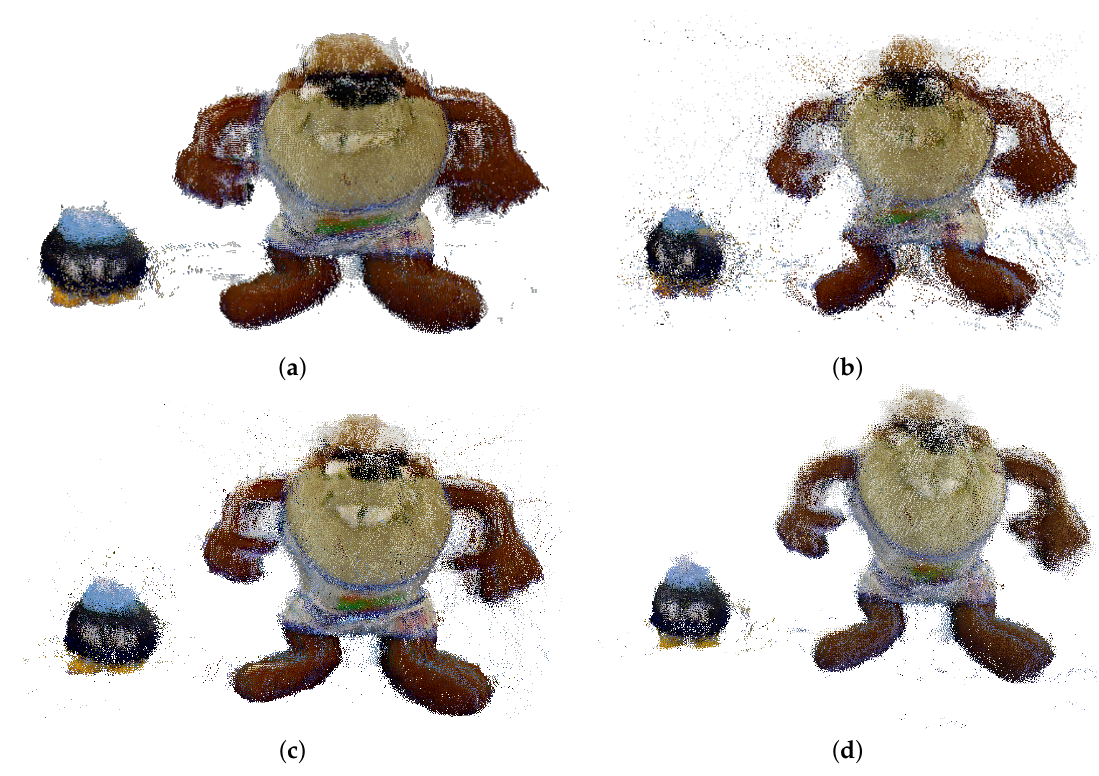
Figure 19. Frontal view of the reconstruction obtained with Primesense Carmine 1.09. ( a ) Default; ( b ) Burrus; ( c ) Bouguet; ( d )